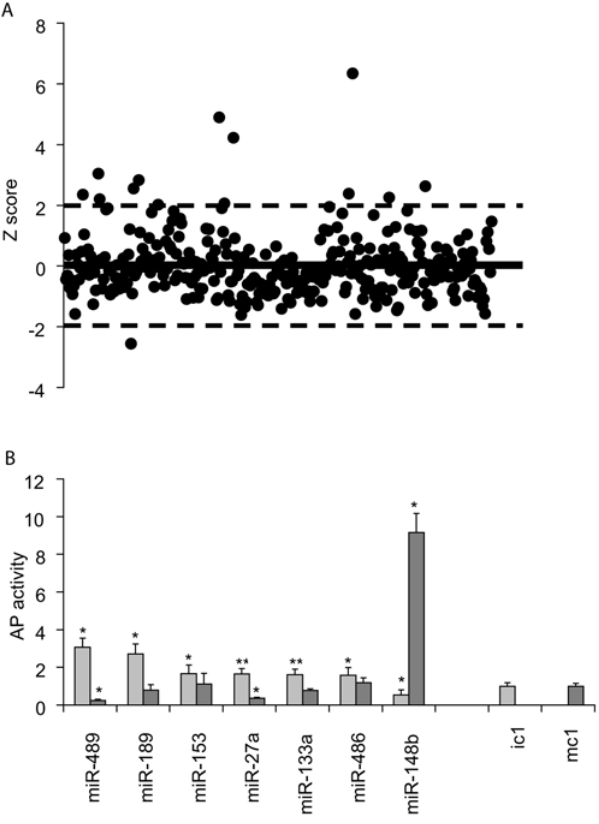
Figure 1. Inhibition of miRNAs dramatically affect osteogenic differentiation of hMSC. (A) Fifteen miRNA inhibitors were selected in the primary screen for their effect on AP activity in differentiated hMSC. Data are representative of a single screen performed in triplicate. (B) Seven inhibitors were confirmed as hits in separate experiments. miRNA mimics for four miRNAs demonstrated no effect on AP activity, -miR-189, -153, -133a and -486. For three other miRNAs, miR -148b, -27a and -489, mimics had an effect that was opposite to one of the corresponding inhibitors. Data are representative of three independent experiments performed in triplicate. (mean + / 2 SD). *, **: Student’s ttest p value between treated cells and corresponding control group, * - p , 0.01, ** - p ,